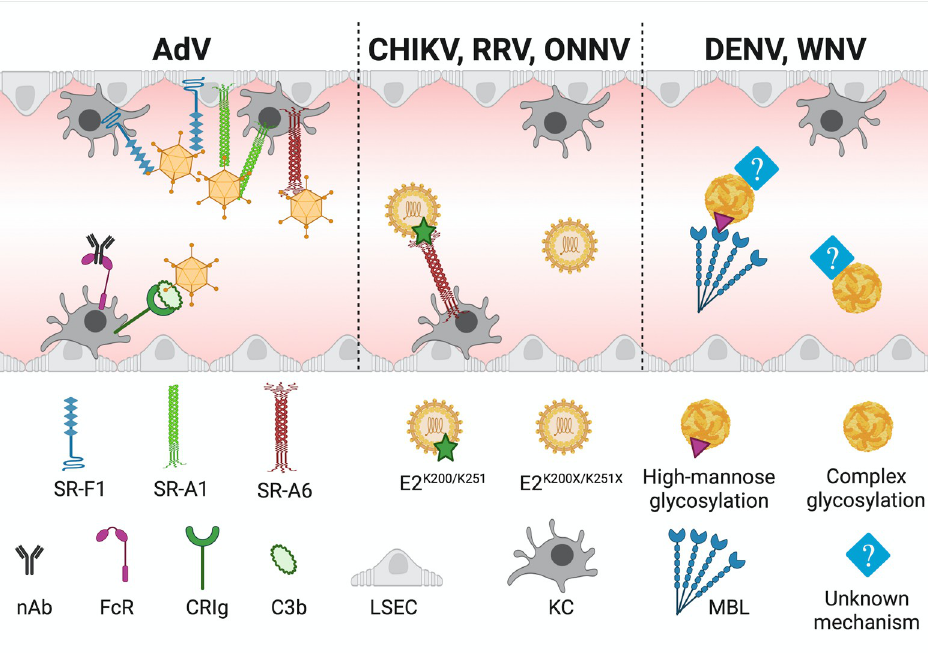
mechanism also exists. This figure was created with BioRender.com. AdV, adenovirus; CHIKV, chikungunya virus; DENV, dengue virus; KC, Kupffer cell; LSEC, liver sinusoidal endothelial cell; MBL, mannose-binding lectin; nAb, natural antibodies; ONNV, o’nyong’nyong virus; RRV, Ross River virus; WNV, West Nile